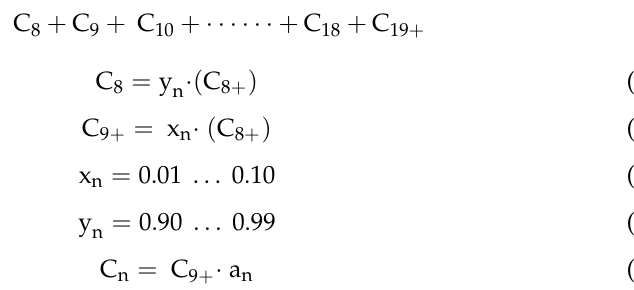
Figure 7. Results of C 9 – C 19 data analysis of Esenyurt RM-A natural gas station.